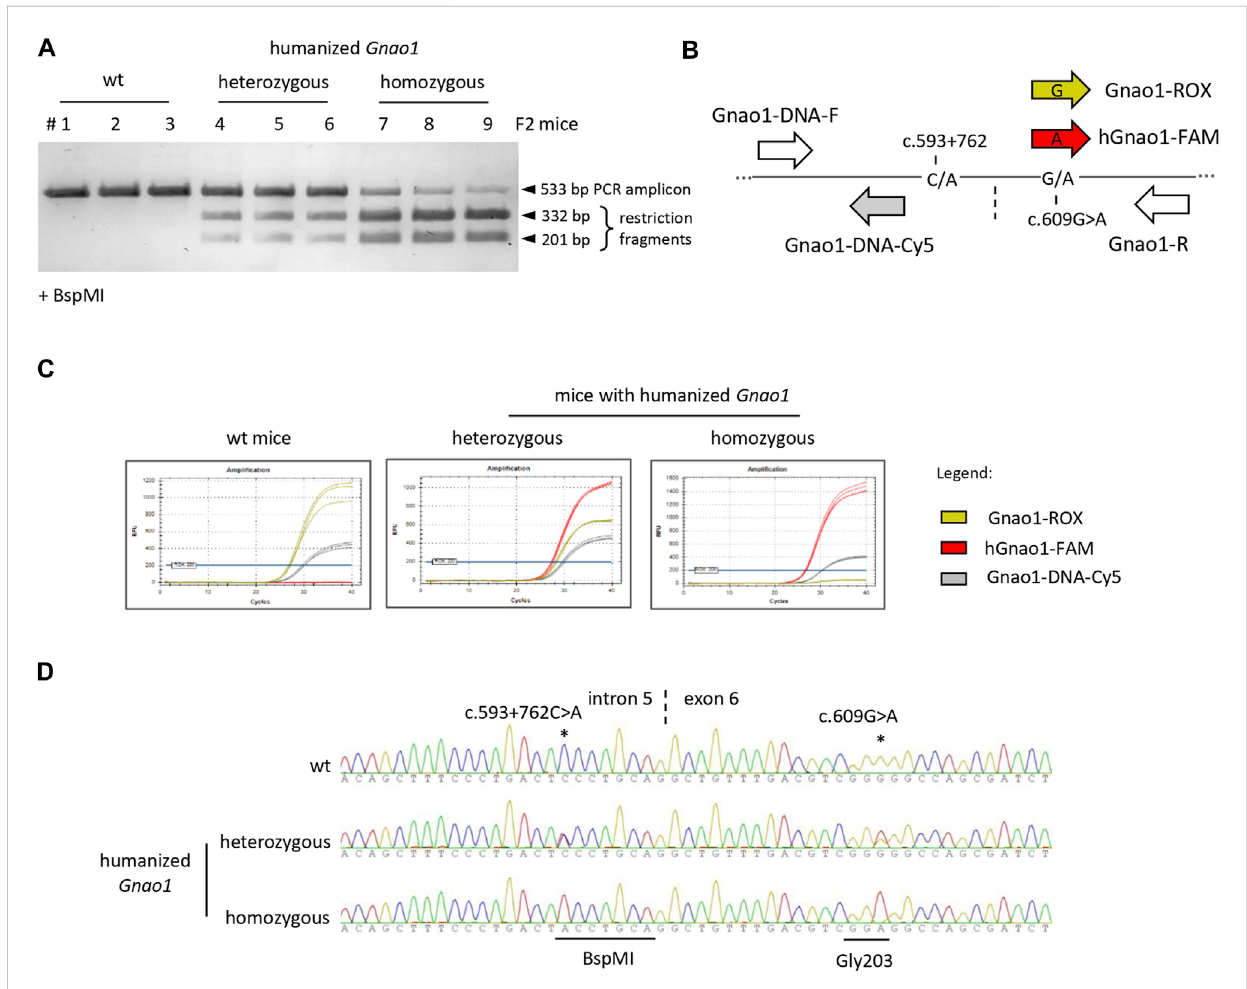
FIGURE 2 Genotyping ofF2littermates withsingle-basesubstitutionsin Gnao1 . (A) BspMI restrictionanalysisofgenomicDNAamplicon(533bp).The traces of the uncut amplicon for the homozygous mice (lanes 7 – 9) are due to insuf fi cient restriction enzyme digestion. (B) Schematically shown the position of primers and probes along the Gnao1 genomic sequence used in allelic qPCR. Gnao1-ROX probe allows detection of the wild-type mouse Gnao1 (GGG triplet for Gly203), hGnao1-FAM is speci fi c for humanized Gnao1 (GGA), Gnao1-DNA-Cy5 probe detects both Gnao1 variants. Vertical dash line marks intron 5-exon 6 junction; (C) Genotyping by allele-speci fi c TaqMan qPCR. Representative ampli fi cation curves demonstrate the selectivity